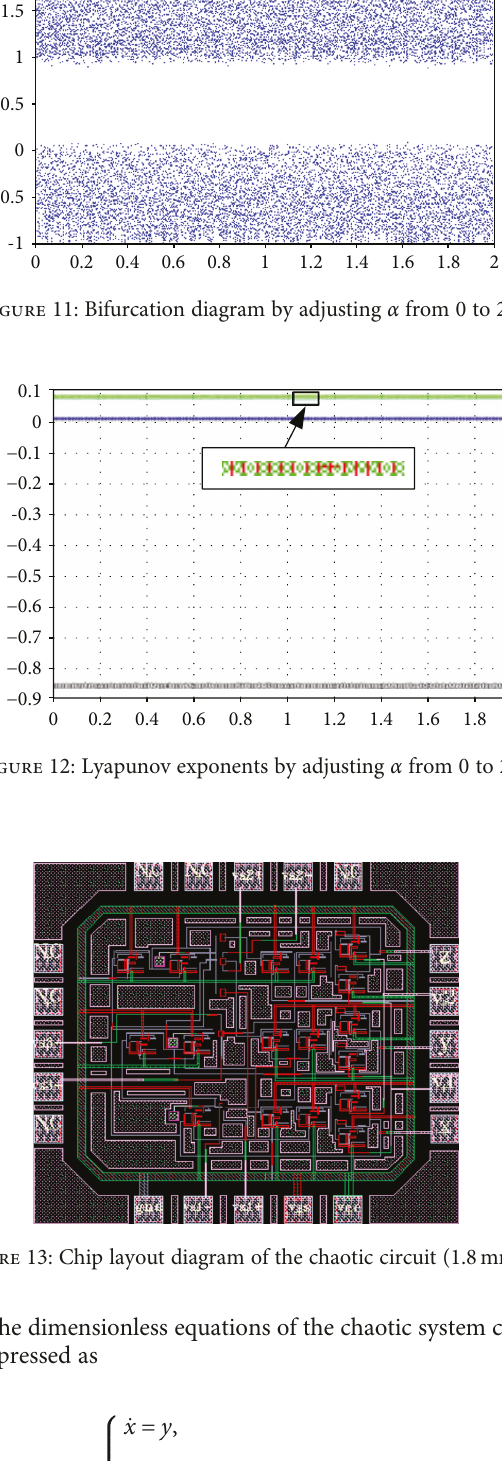
Figure 13: Chip layout diagram of the chaotic circuit (1.8mm 2 ).